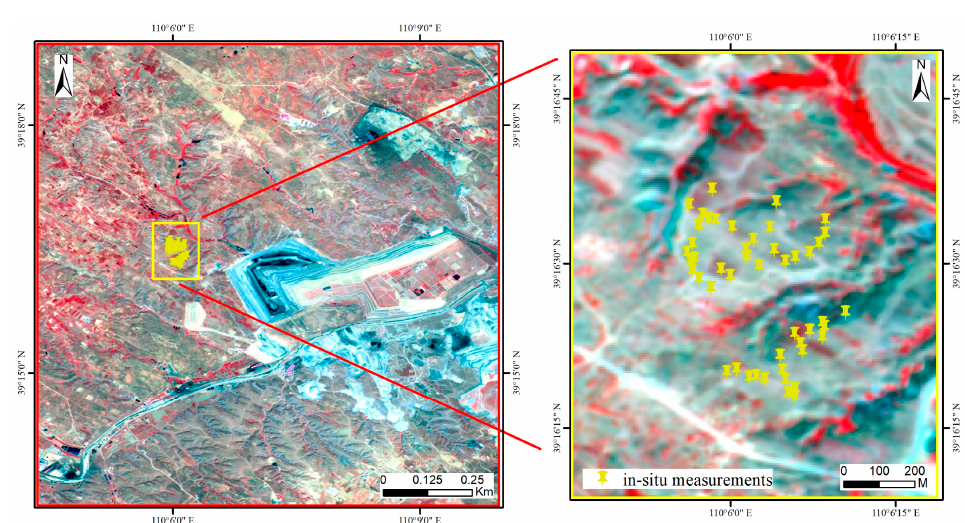
Figure 3. Spatial distribution of the in situ measurements data.